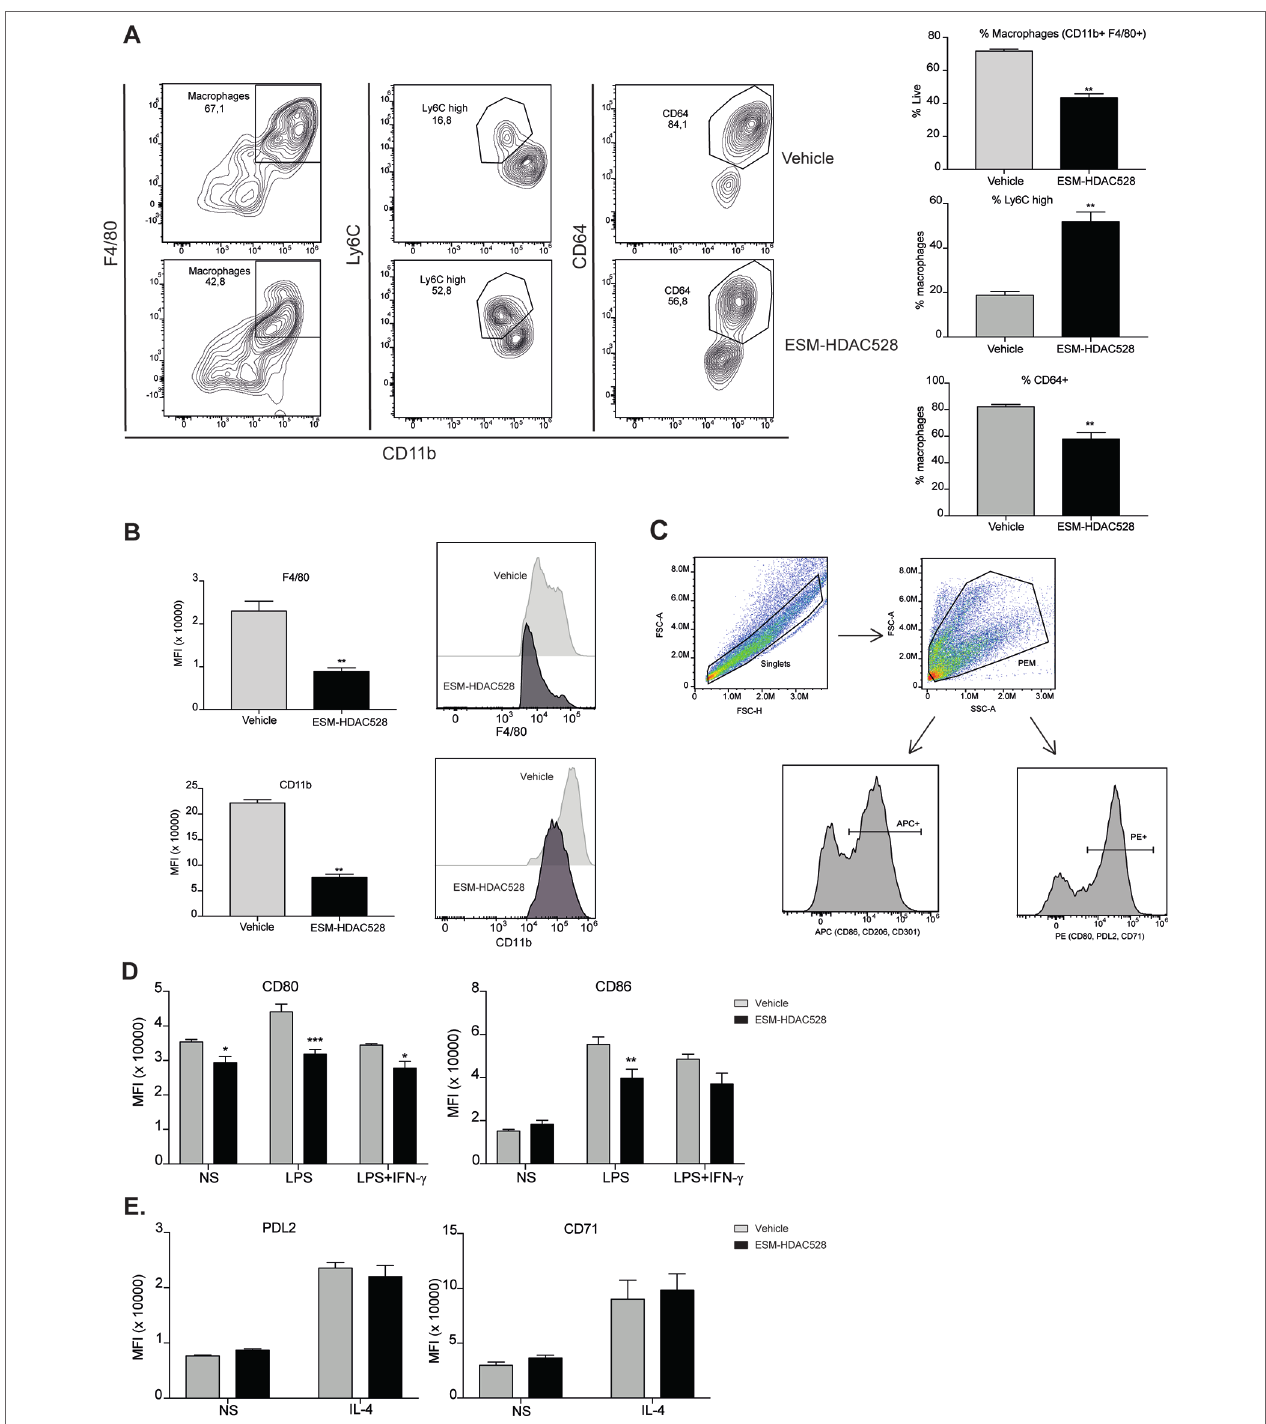
FIGURE 2 | ESM-HDAC528 treatment modulates PEM maturation and surface marker expression. (A) Percentage of mature macrophages (CD11b+ and F4/80+), and the maturation markers Ly6C and CD64 within macrophage populations in the freshly isolated cells 24 h after injection n = 6 per group. (B) MFI of F4/80 and CD11b in the mature macrophages. n = 6 per group. (C) General gating strategy for activation marker expression on PEMs after attachment and 24 h stimulation for activation. Antibodies were conjugated to either APC or PE depending on the panel. (D) . MFI of the positive peaks for the pro-inflammatory surface markers in PEMs Isolated, attached and stimulated for 24 h with LPS (10 ng/ml) or LPS (10 ng/ml) + IFN- γ (10 U/ml). n = 6 per group. (E) MFI of the positive peaks for the alternative activation surface markers in PEMs attached and stimulated for 24 h with IL-4 (20 ng/ml). n = 6 per group. Statistical significance was determined by unpaired t -test (A and B) or two-way ANOVA with Bonferroni correction (D and E) (p < 0.05) All error bars represent the SEM. ns = p value > 0.05, * p value ≤ 0.05, ** p value ≤ 0.01, *** p value ≤